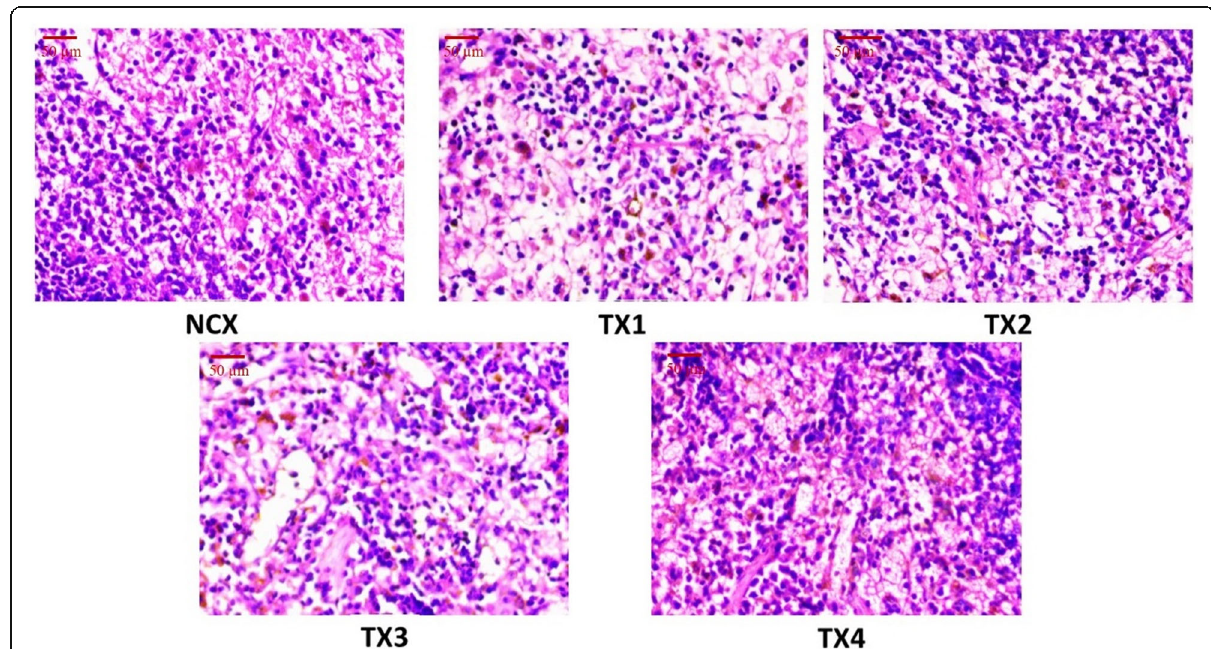
Fig. 6 The histopathology of spleen from the different group of swiss albino mice (40 × magnification; Scalar bar: 50 μ m). No significant damage was observed in the spleen tissue of any treated groups rats. The micropictograph showed the normal white and red pulp areas with no cell breakage in the splenic parenchyma when compared to normal control group (NCX). Where NCX: Normal control group; TX1: Sub-acute toxicity group 1 (250 mg/kg/day/p.o); TX2: Sub-acute toxicity group 2 (500 mg/kg/day/p.o); TX3: Sub-acute toxicity group 3 (1000 mg/kg/day/p.o); TX4: Sub-acute toxicity group 4 (2000